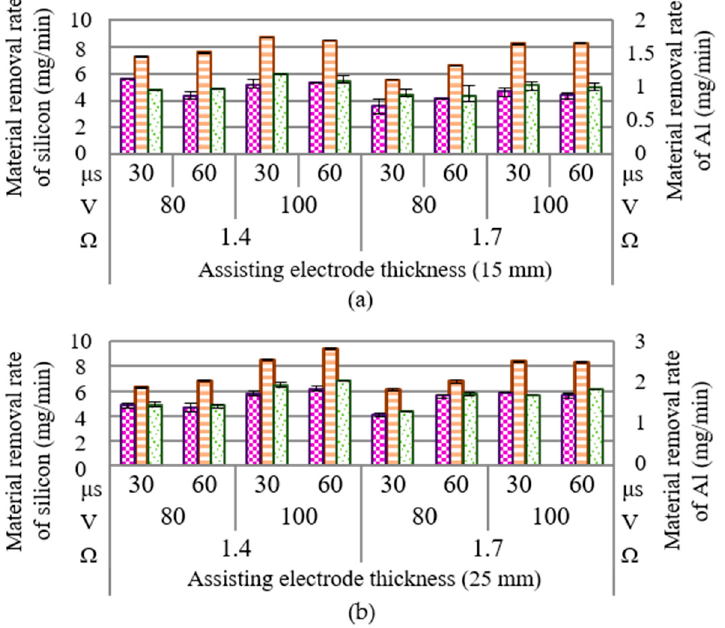
Figure 11. Material removal rate of polycrystalline silicon with assisting electrodes of: ( a ) 15 mm; ( b ) 25 mm.